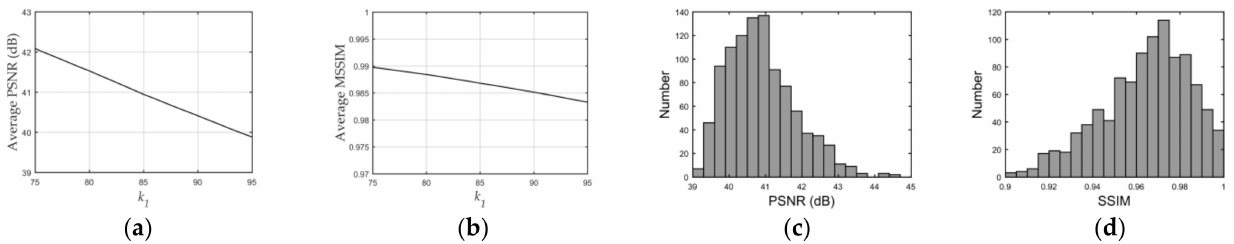
Figure 12. PSNR and SSIM with different and selected k 1 . ( a ) and ( b ) are average PSNR and SSIM values with different k 1 ; ( c ) and ( d ) are PSNR and SSIM values with selected k 1